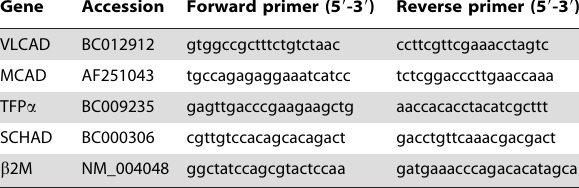
Table 2. Real-time PCR primer sequences. Gene